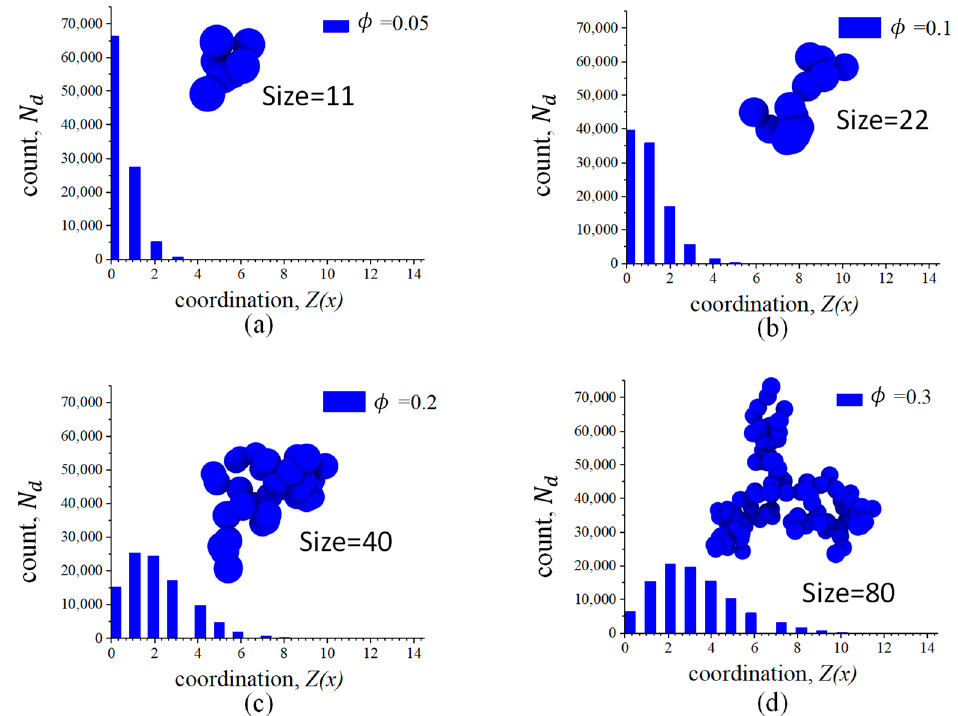
Figure 9. Coordination number analysis with different volume fractions: ( a ) (cid:2038) = 0.05; ( b ) (cid:2038) = 0.1; ( c ) (cid:2038) = 0.2; ( d ) (cid:2038) = 0.3.